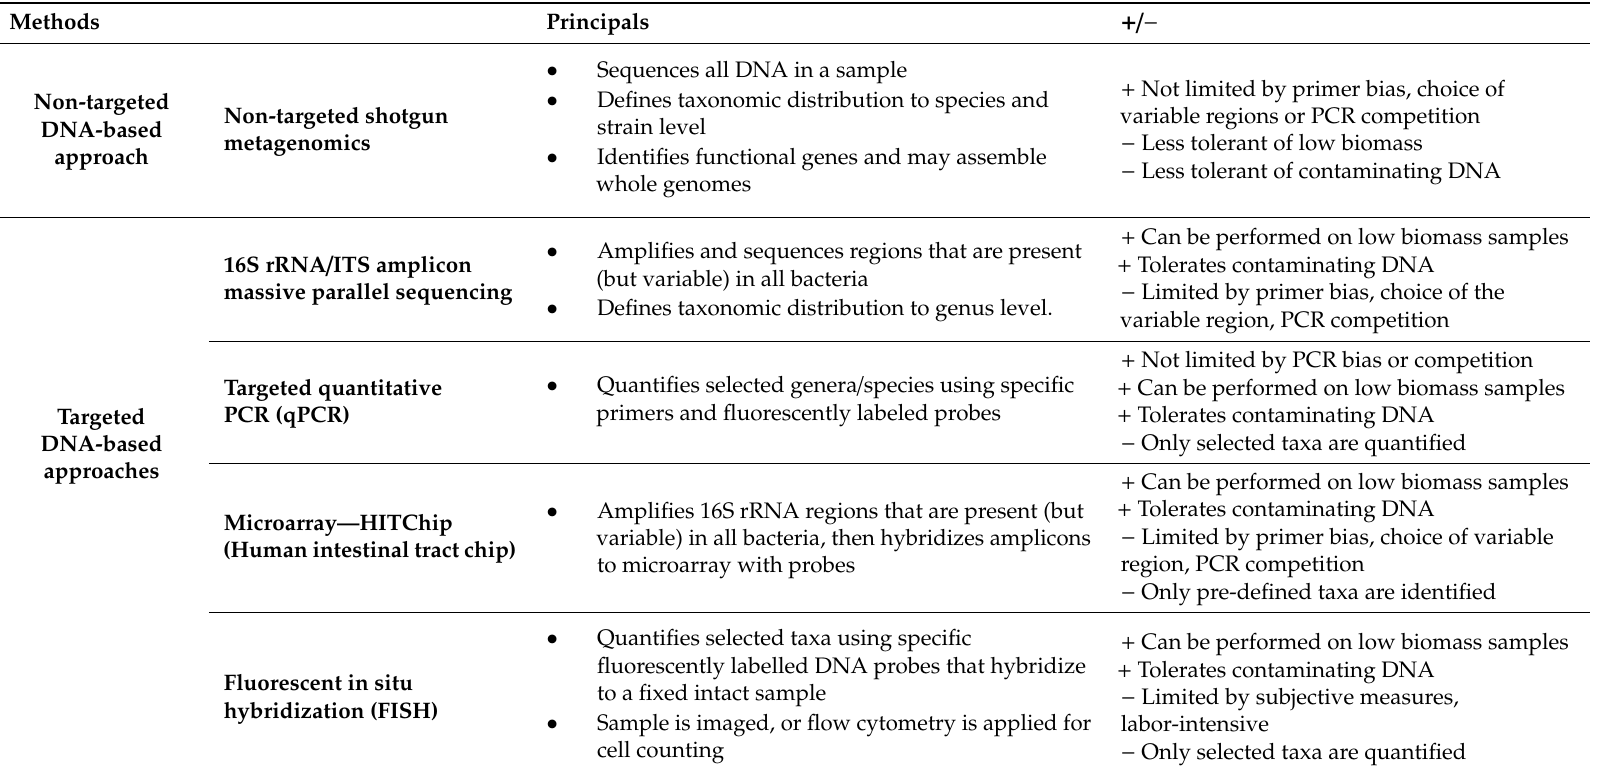
Table 1. Methods used for microbiota analyses in the publications covered in the current